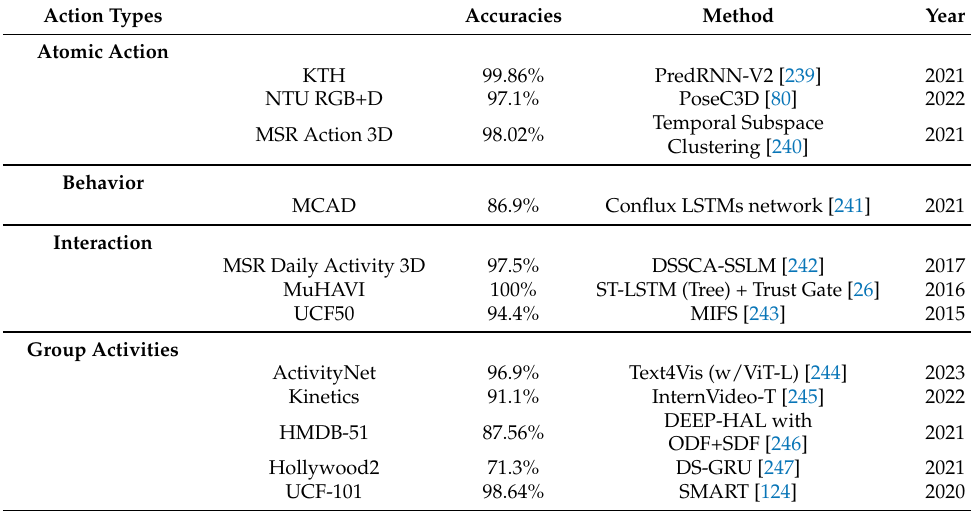
Table 5. Accuracies on Polular